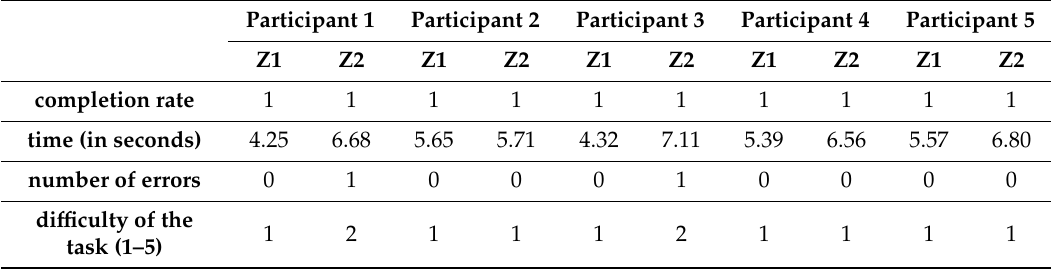
Table 1. Usability tests results for Prototype A (e ff ectiveness and e ffi ciency).